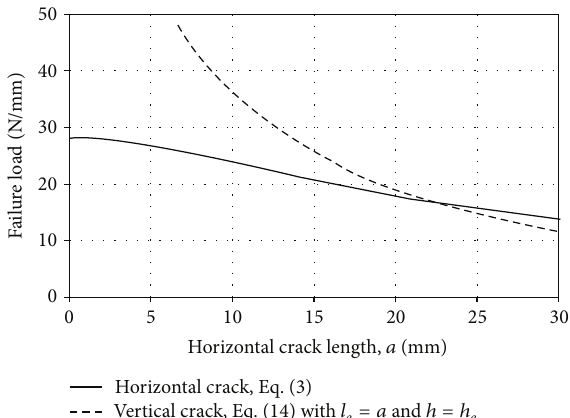
Figure 9: Example of propagation of initial horizontal crack in bottom rail and possible change to vertical